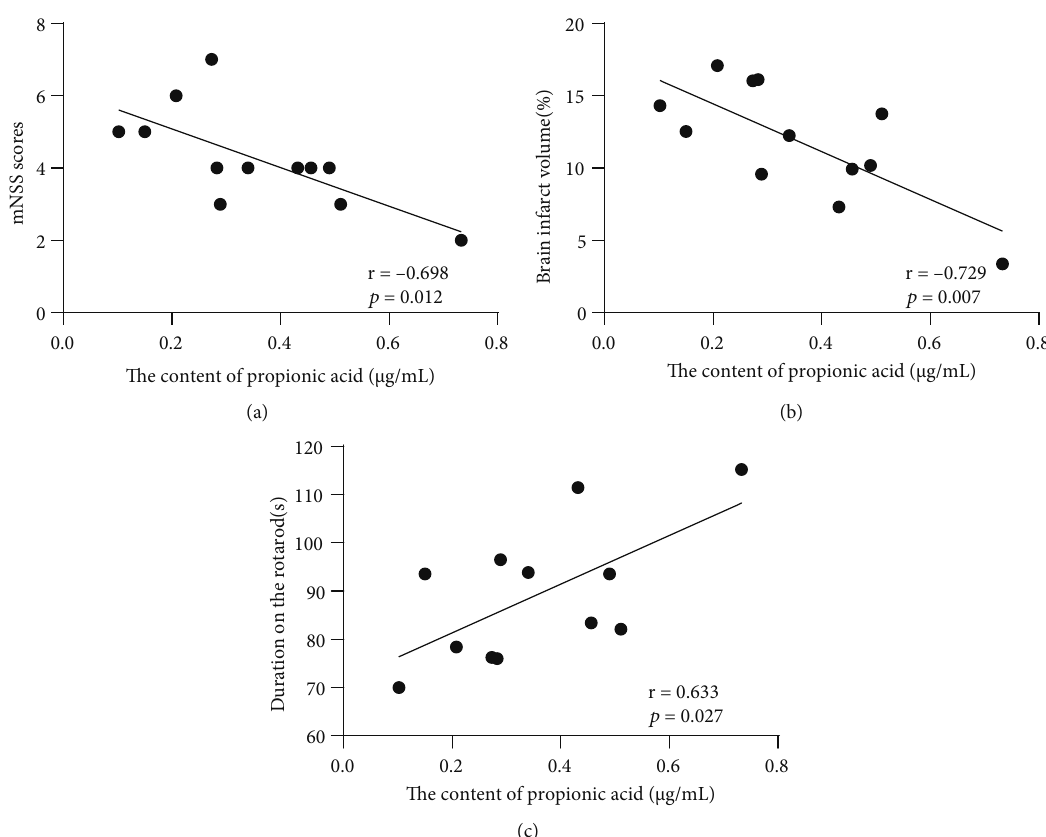
Figure 8: Correlation between the concentrations of propionic acid and clinical features. Pearson ’ s correlation analyses between the concentrations of propionic acid and the value in (a) mNSS, (b) brain infarct volume, and (c) rotarod. Signi fi cant correlations were determined based on < – 0.5 Pearson r < 0 : 5 and P < 0 : 05 . Abbreviations: mNSS: modi fi ed neurological severity ( r = − 0 : 698 and P < 0 : 05 ) and the percentage of brain infarct volume ( r = − 0 : 729 and P < 0 : 01 ) (Figures 8(a) and 8(b)).